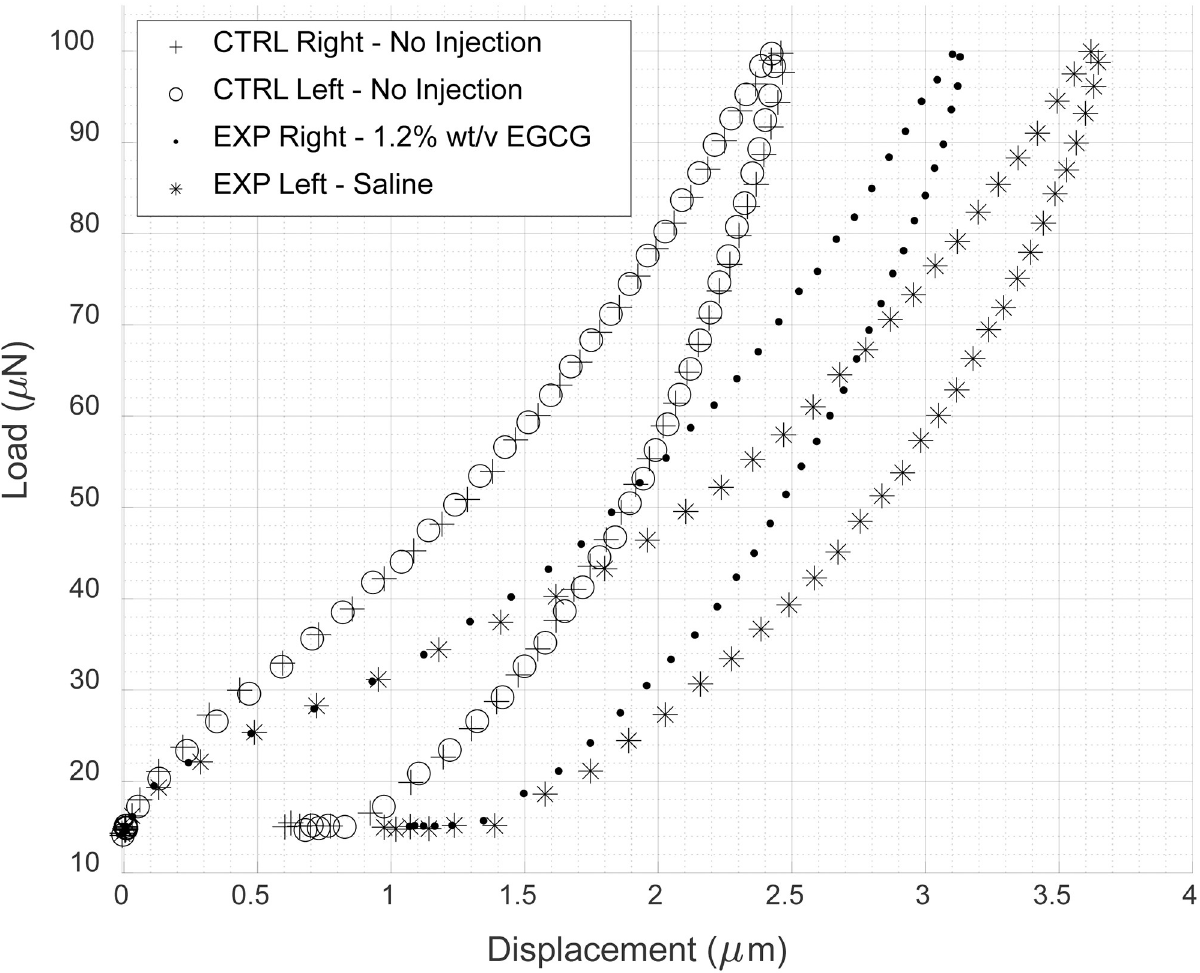
Fig 8. Load v displacement curves for four indentations. From a control animal shown is an un-injected right knee (+) and un-injected left knee (o). From an experimental animal shown is an EGCG-injected right knee (.) and saline-injected left knee ( �